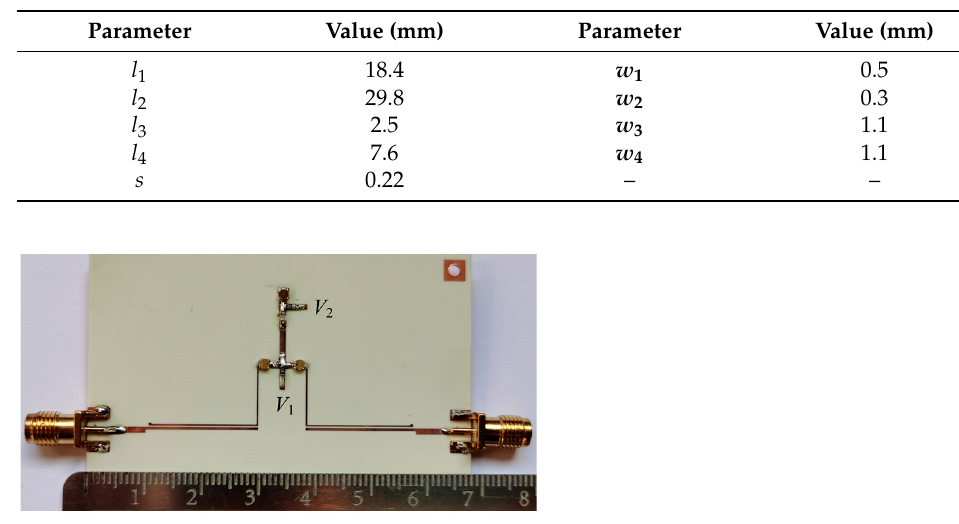
Figure 7. The photograph of the proposed filter.